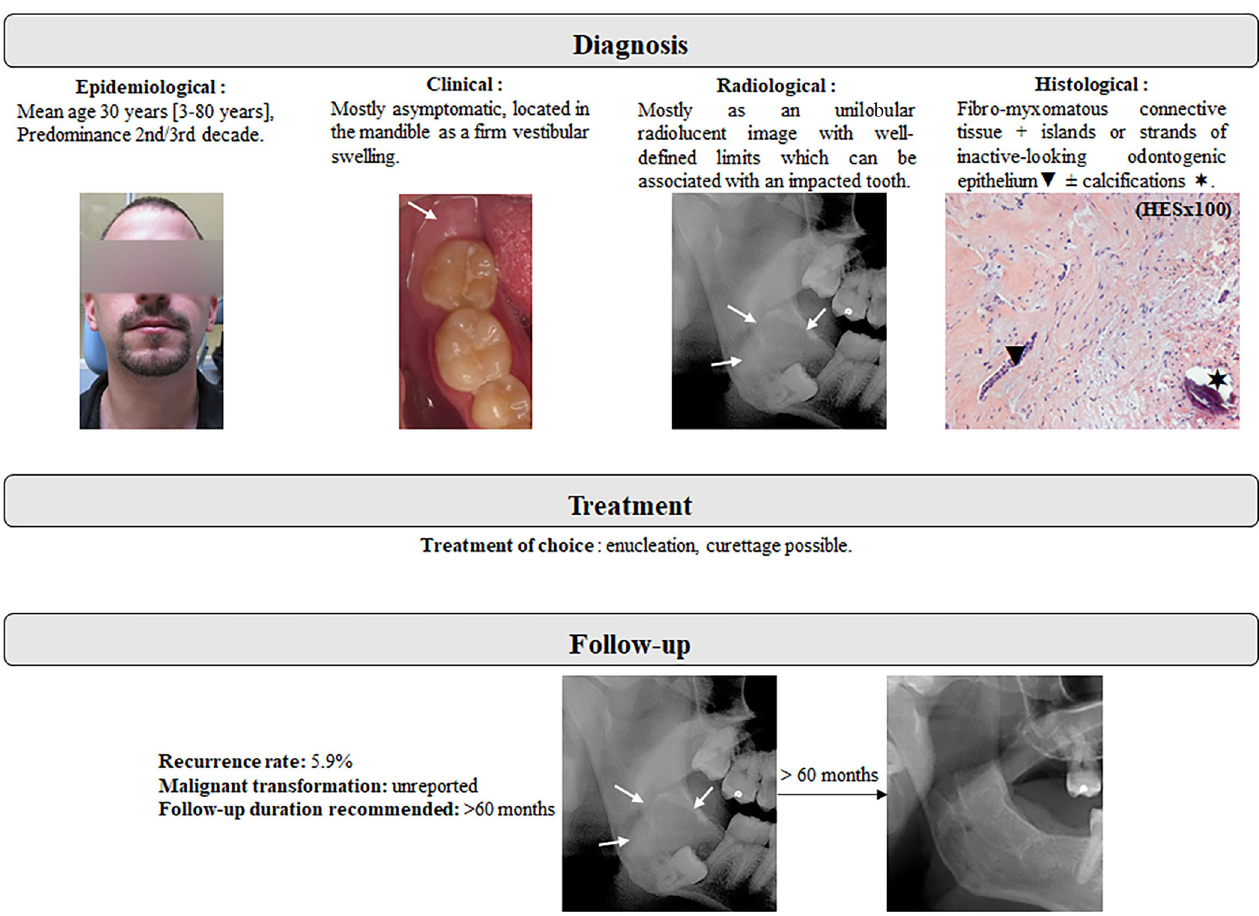
Fig. 5. Pedagogical summary of the management of a central odontogenic fi